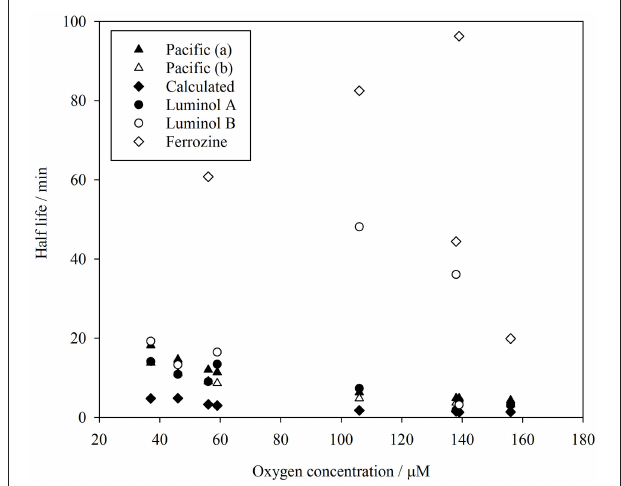
FIGURE 5 | Comparison of Fe(II) half-life (ln(2)/k 1 ) derived from measurements in surface Pacific seawater (Roy and Wells, 2011), from method comparison experiments reported here, and calculated from rate constants ( Millero et al., 1987